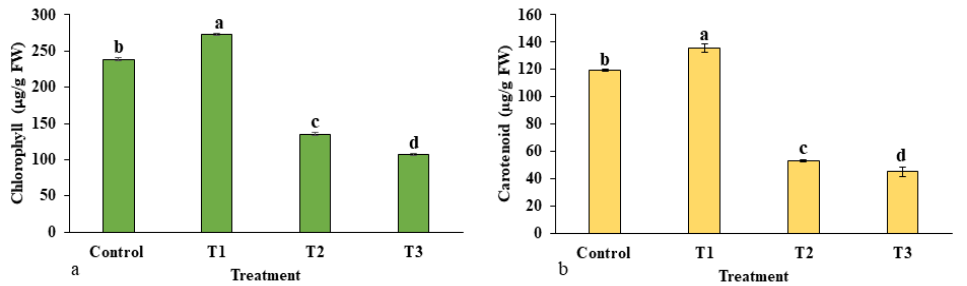
Figure 7. Effects of ZnO-NP on photosynthetic pigments: ( a ) total chlorophyll; ( b ) carotenoid content. Treatments including control (0 mg/L, ZnO-NPs); T1 (10 mg/L, ZnO-NPs); T2 (20 mg/L, ZnO-NPs) and T3 (40 mg/L, ZnO-NPs). Different letters designate a significant difference by Duncan’s multiple range tests at p < 0.05.